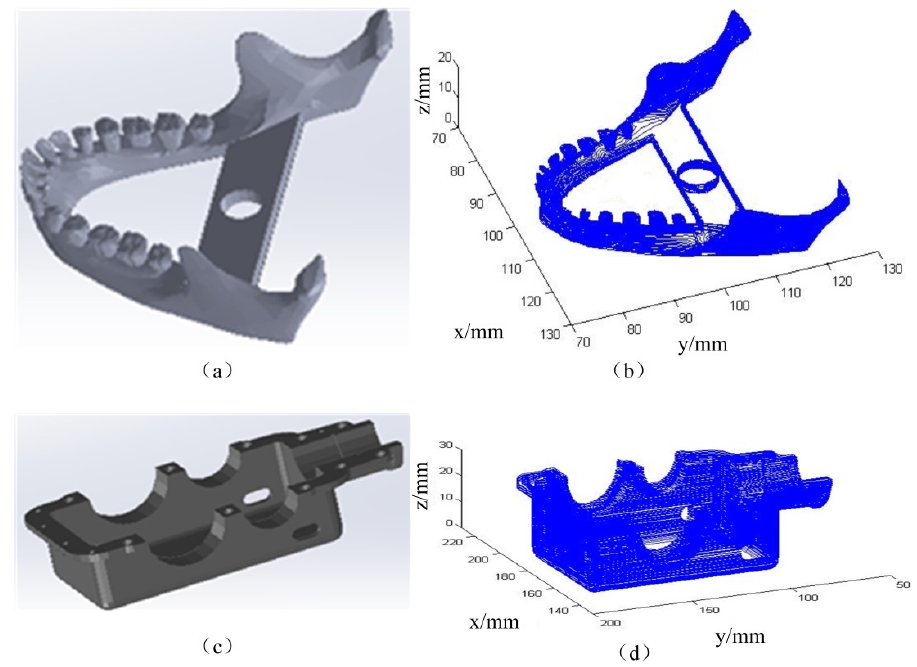
Figure 5. STEP modes and their slicing simulation results. ( a ) STEP model of the lower teeth; ( b ) slicing simulation of the lower teeth; ( c ) STEP model of the gearbox base; ( d ) slicing simulation of the gearbox base.